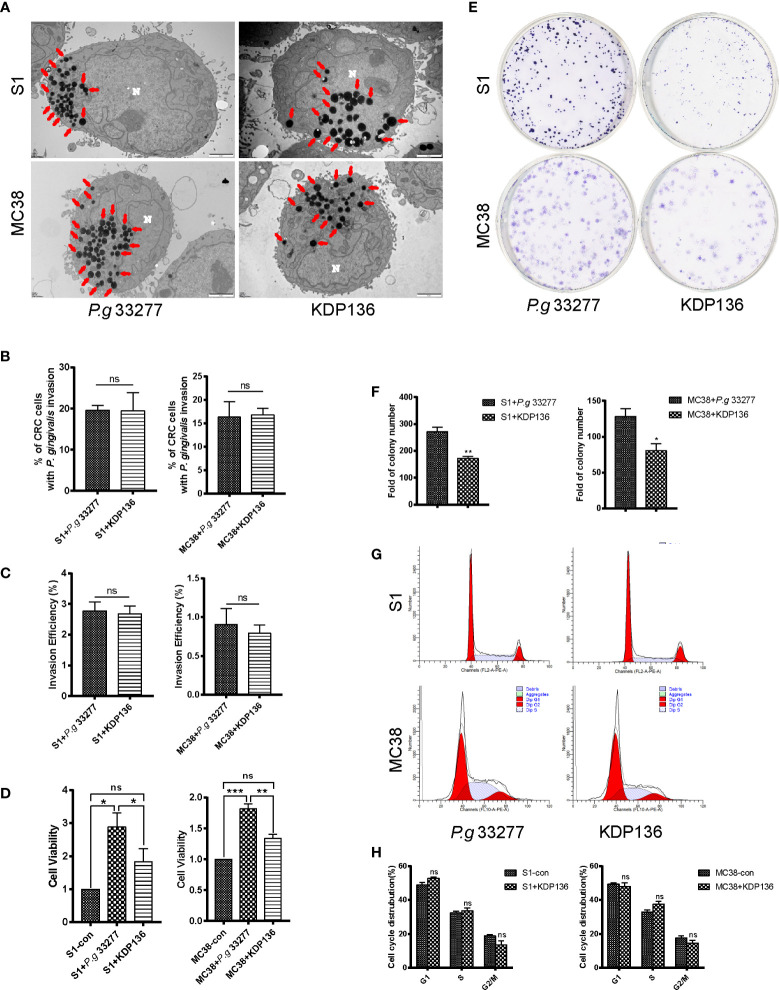
The invasion ability and pro-proliferation ability of KDP136 to S1 and MC38 cells. (A, B) TEM results indicate that P. gingivalis 33277 and KDP136 can intracellularly invade S1 and MC38 cells and the percentage of CRC cells with P. gingivalis invasion showed no significant difference between P. gingivalis 33277 and KDP136 groups. (C) Antibiotic protection assay shows that P. gingivalis 33277 and KDP136 can survive inside the cell at 24 h after infection and the invasion efficiency of P. gingivalis 33277 and KDP136 showed no significant difference. (D) CCK8 assay examination of the proliferation of S1 and MC38 cells pretreated with P. gingivalis 33277 and KDP136 for 24 h. (E, F) Colony formation assay examination of the proliferation of S1 and MC38 cells pretreated with P. gingivalis 33277 and KDP136. (G, H) Cell cycle analysis of S1 and MC38 cells pretreated with P. gingivalis 33277 and KDP136 detected by flow cytometry. Invasion efficiency (%) = CFU of P. gingivalis inside CRC cells/CFU of P. gingivalis in initial inoculum. CFU, colony forming units. Red arrows, P. gingivalis infection in the cytoplasm. N, nucleus. *P < 0.05, **P < 0.01, ***P < 0.001. ns, nonsignificant. KDP136, a gingipain-deficient mutant of P. gingivalis 33277.